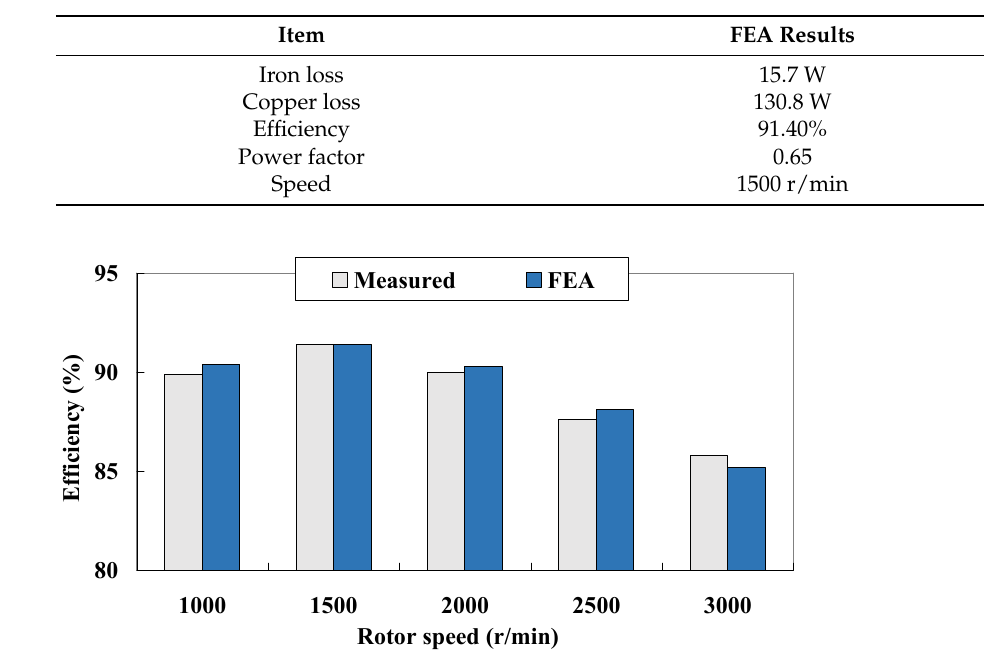
Figure 17. Comparison of the measured and FEA calculated torque results: ( a ) torque values by different current and rotor position; ( b ) torque values by different current and current angle. Table 8. Power loss and efficiency at rated operation.